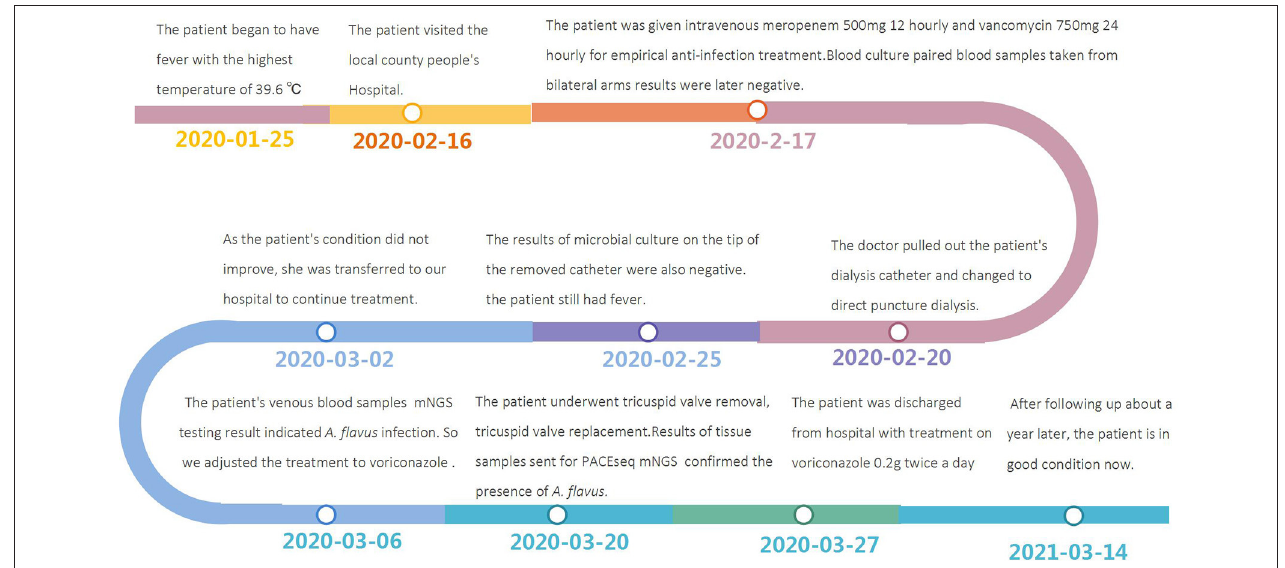
FIGURE 4 | Timeline of the reported